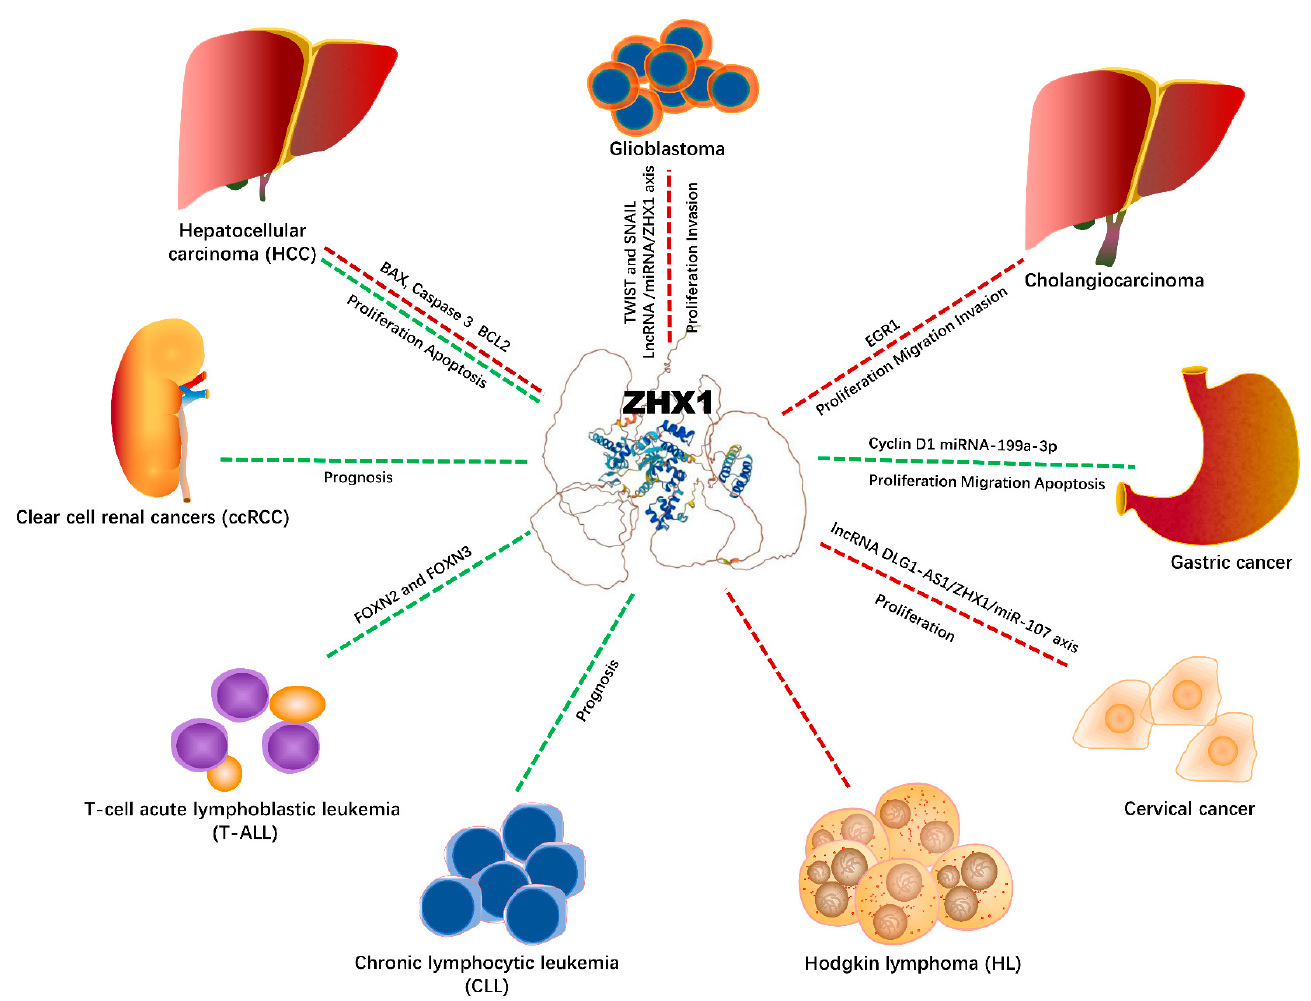
Figure 1. ZHX1 and cancers: biological functions and potential signaling networking.